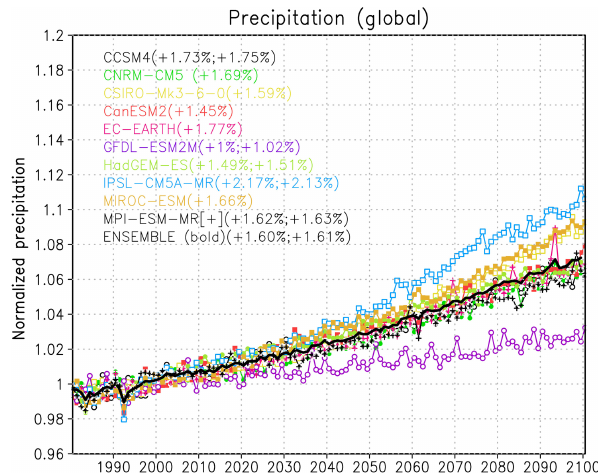
Figure 1. Normalized mean global precipitation from 1981 to 2100 in the 10 CMIP5 GCM simulations for the RCP8.5 scenario used by Giorgi et al. (2014a), along with their ensemble average. The first number in parentheses shows the corresponding mean global precipitation change per degree of global warming, while the sec- ond shows (for a subset of models with available data) the same quantity for global surface evaporation. The annual precipitation is normalized by the mean precipitation during the reference period 1981–2010; therefore, a value of, e.g., 1.1 indicates an increase of 10%.